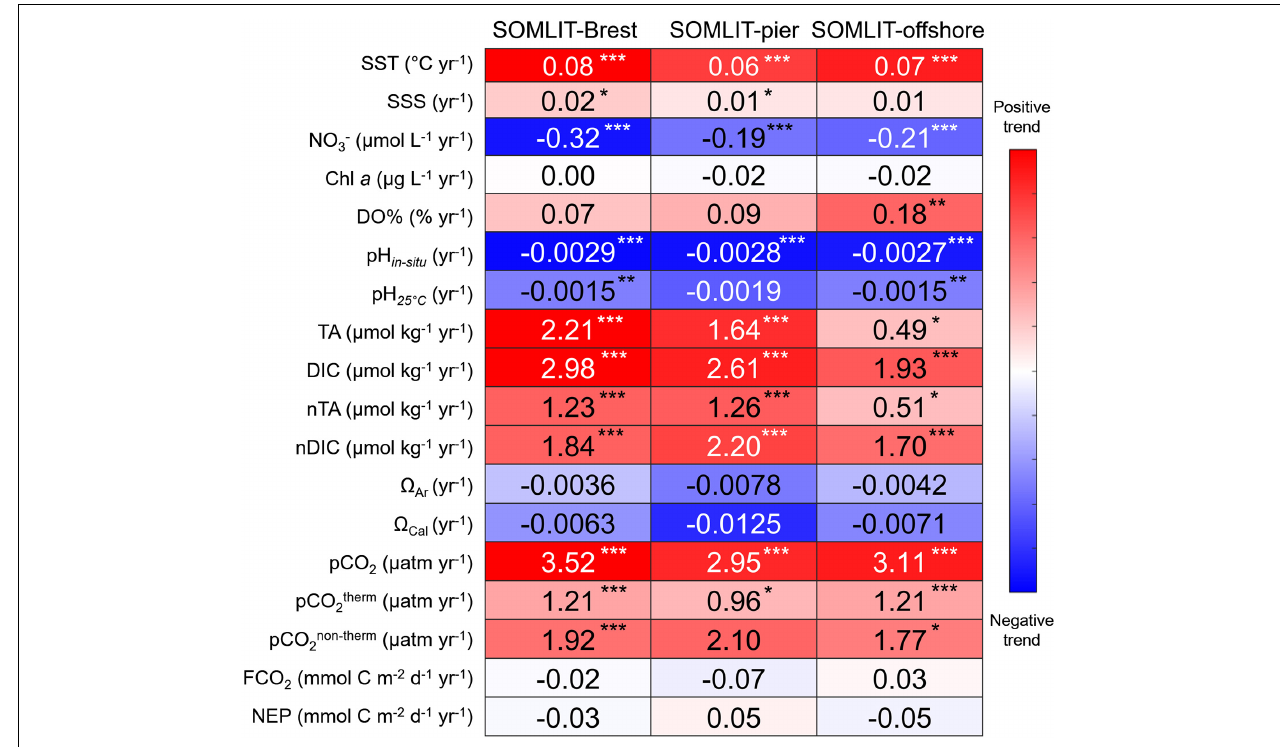
FIGURE 6 | Heatmap of the trends of monthly anomalies of the parameters collected at the three SOMLIT stations for the January 2008 to December 2017 period (see Section “Weekly and Bimonthly Measurements of the Long-term Time-Series” for details on sampling dates). Red represents a positive trend, blue denotes a negative trend, and white indicates no trend, with the maximum and minimum attributed based on the maximum and the minimum of the trends of each parameter. The color bar values of pH 25 ◦ C , nTA, nDIC, pCO 2 therm , and pCO 2 non − therm were attributed by the color bar of pH in situ , TA, DIC, and pCO 2 , respectively. Asterisks represent p -values: *** p -value < 0.001, ** p -value < 0.01, * p -value < 0.05, and missing asterisk indicates non-significant